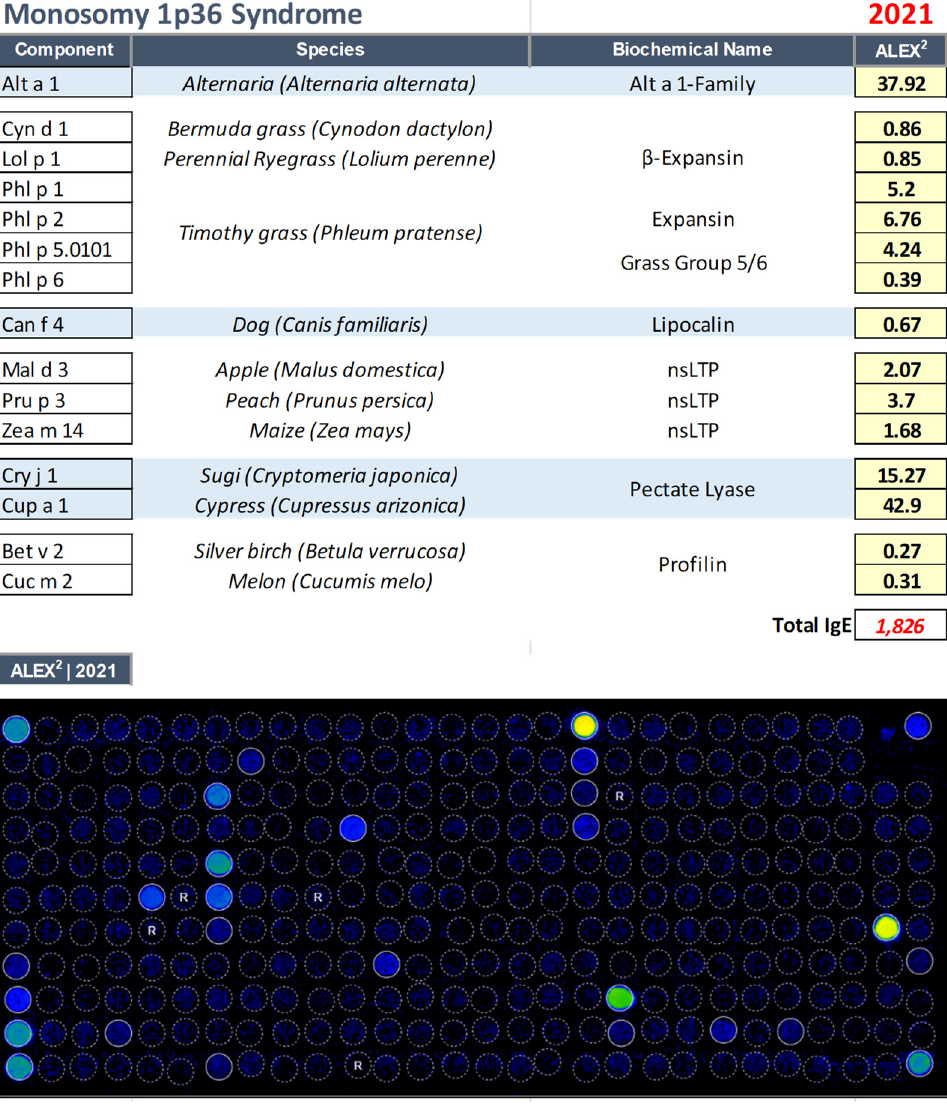
Figure 3. IgE sensitization profile as evaluated through multiplexed proteomic evaluations with Allergy Explorer–ALEX2 ® 2 macroarray in the patient affected by Monosomy 1p36 Syndrome Allergy Explorer–ALEX2®2 macroarray in the patient affected by Monosomy 1p36 Syndrome (OMIM: (OMIM: 607872).